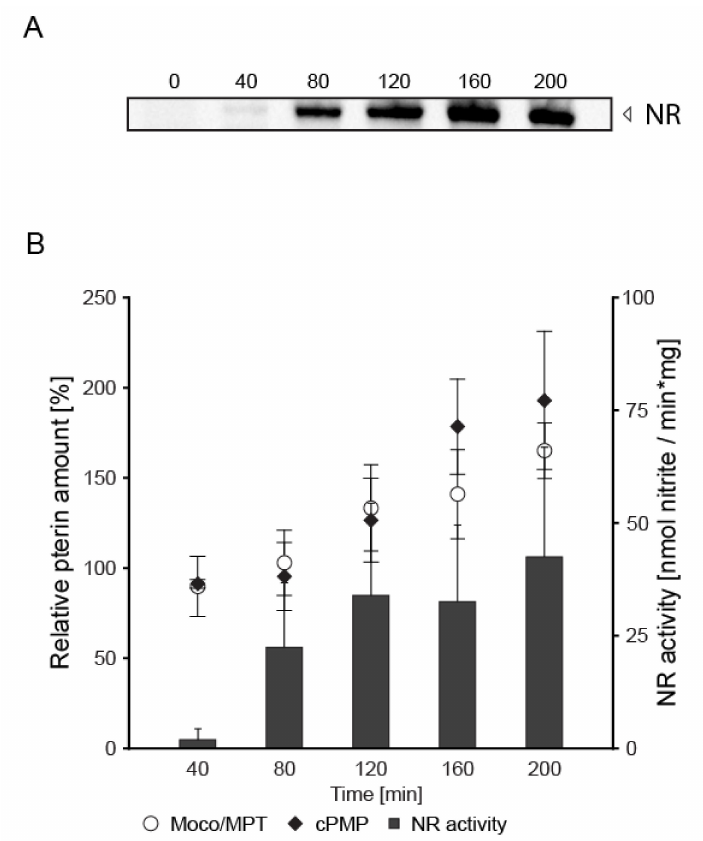
Figure 2. Connection of the Neurospora crassa Mo-metabolism with the nitrate assimilation pathway. ( A ) Western blot-based detection of nitrate reductase (NR) in Neurospora crassa. ( N. crassa ) crude extracts obtained at the indicated time points upon growth under nitrogen derepressing (N-derepressing) and nitrate-inducing conditions. ( B ) Quantitative detection of cyclic pyranopterin monophosphate (cPMP), molybdopterin (MPT), molybdenum cofactor (Moco), and NR activity in N. crassa crude extracts obtained at the indicated time points under N-derepressing and nitrate-inducing conditions. Four biological replicates were analyzed. Error bars indicate the standard